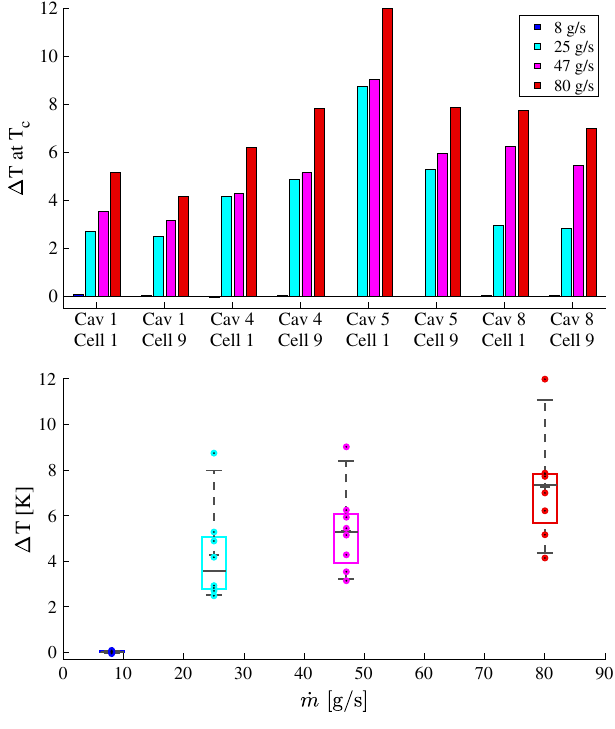
FIG. 3. Top: Temperature difference between the top and the bottom of the cavity achieved during cooldown in the cryomod- ule based on measurements of the Fermilab LCLS-II prototype cryomodule. Four different cooldowns were performed, each with a different mass flow (note that mass flow values are measured only for the entire cryomodule, not individual cavities). Bottom: The same data plotted as Δ T vs mass flow. “ Box plots ” are added to show statistical spread in the data, with dashed lines showing maximum and minimum, colored rectangles showing range of second and third quartile, horizontal black line showing the median, and black “ þ ” showing the